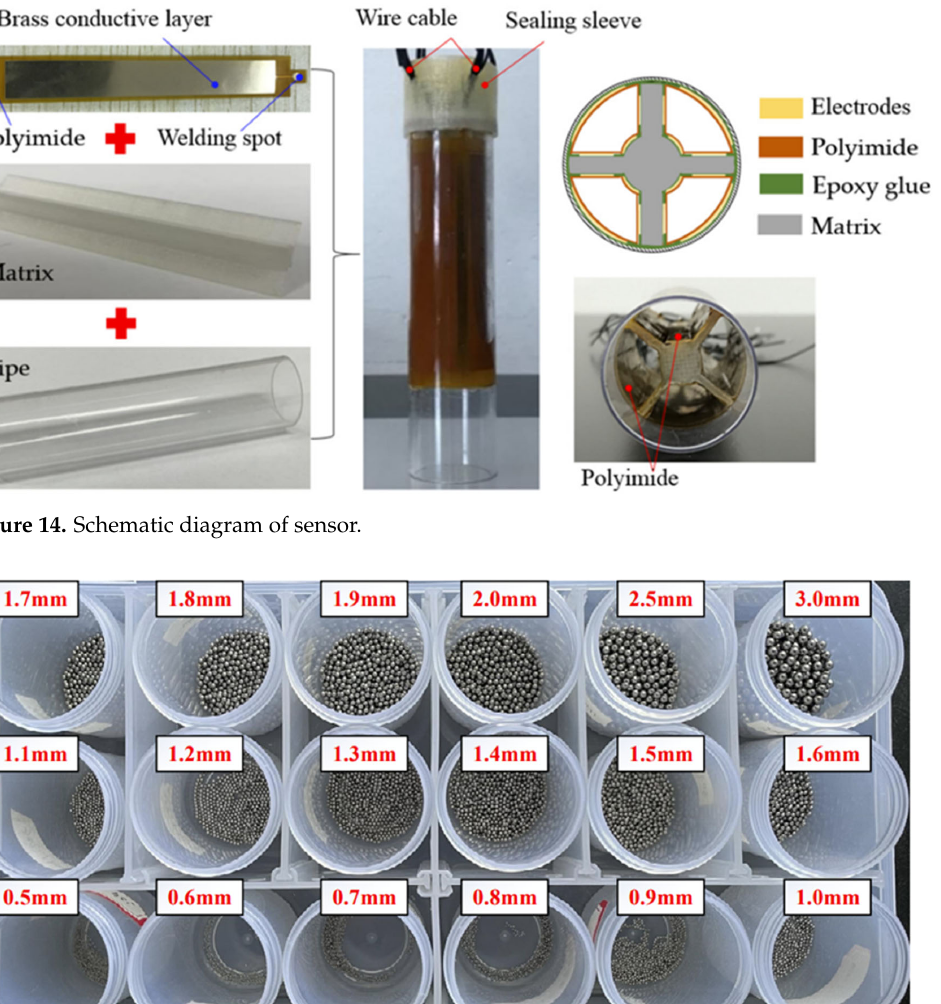
Figure 15. Wear particles used in the experiment.